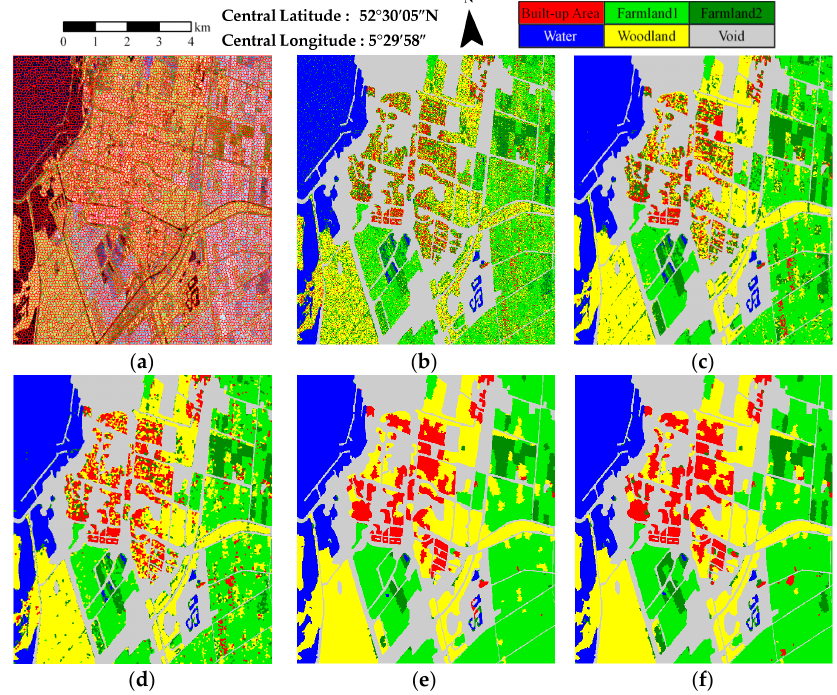
Figure 9. Classification results of the RADARSAT-2 image with different methods: ( a ) superpixel map; ( b ) KSEM; ( c ) KSEM-PLR; ( d ) SP-KSEM; ( e ) SP-WSEM-PLR (Wishart distribution SEM (WSEM)); and ( f ) SP-KSEM-PLR.